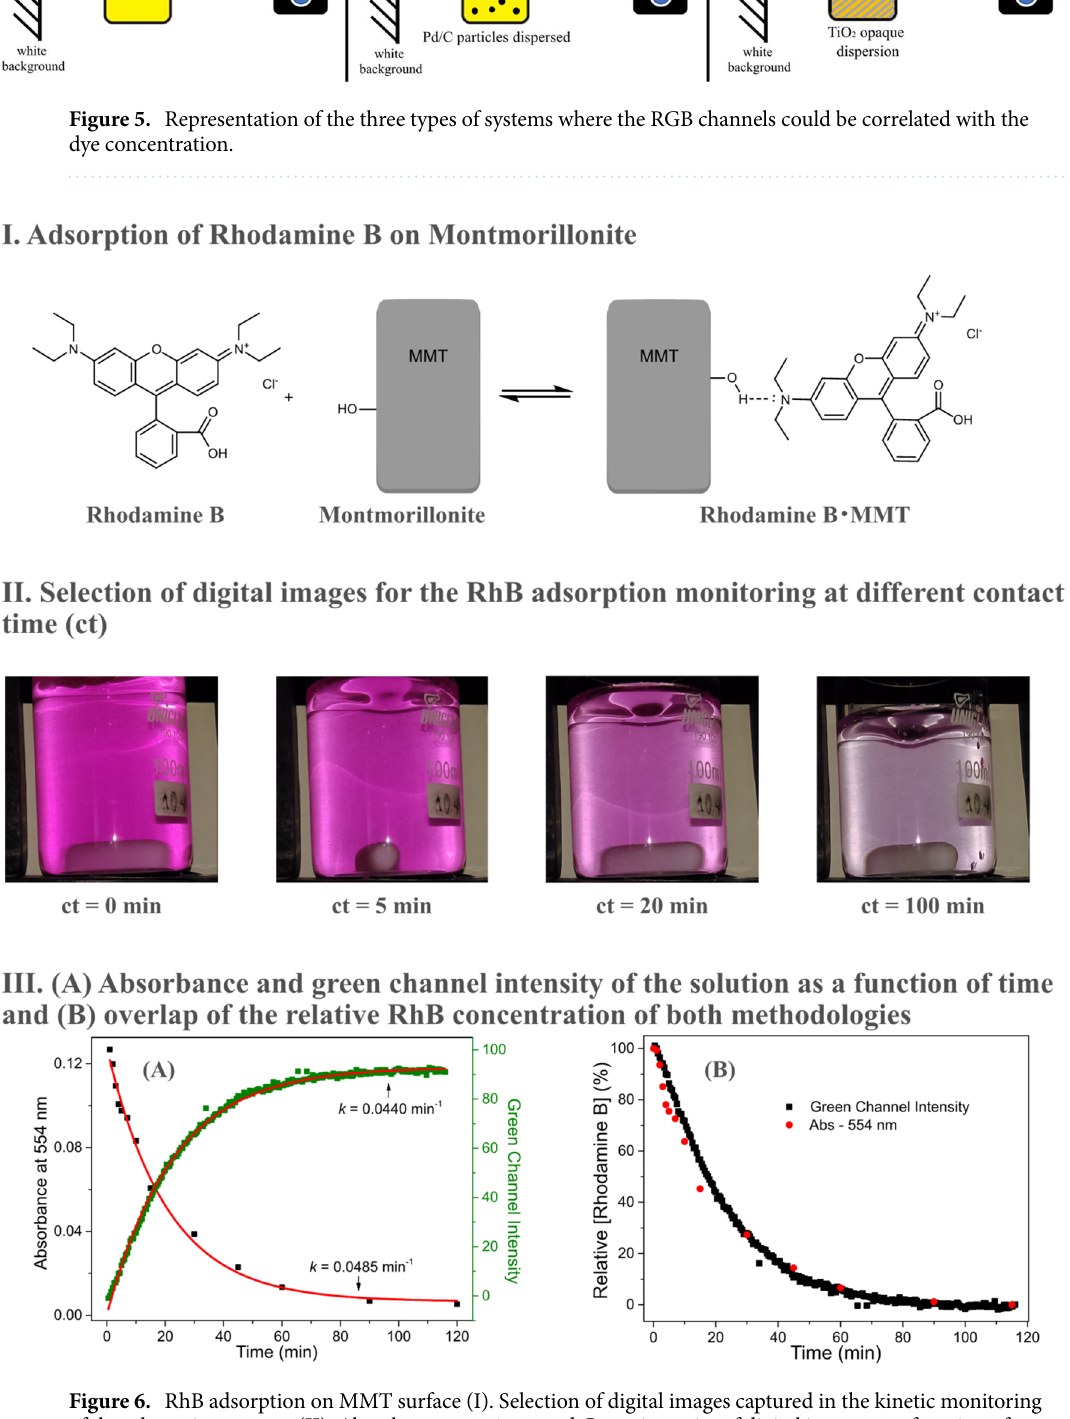
Figure 6. RhB adsorption on MMT surface (I). Selection of digital images captured in the kinetic monitoring of the adsorption process (II). Absorbance at 554 nm and Green intensity of digital images as a function of adsorption time (III- A ). Overlapping of the relative concentration of RhB calculated by both methodologies (III- B